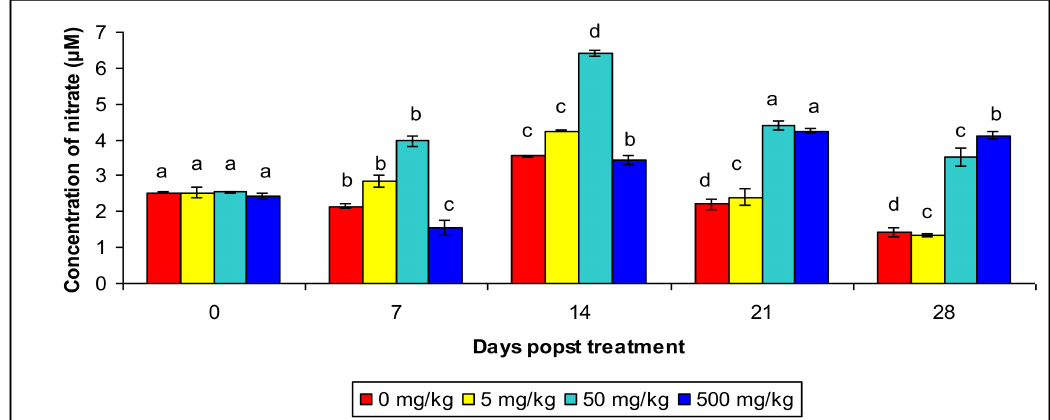
Figure 7. Effect of C. aerea extract on the reactive nitrogen species production by peripheral blood leukocytes in L. rohita (values are mean ± SE). Mean values with different superscript within a column for a parameter are significantly different ( p <